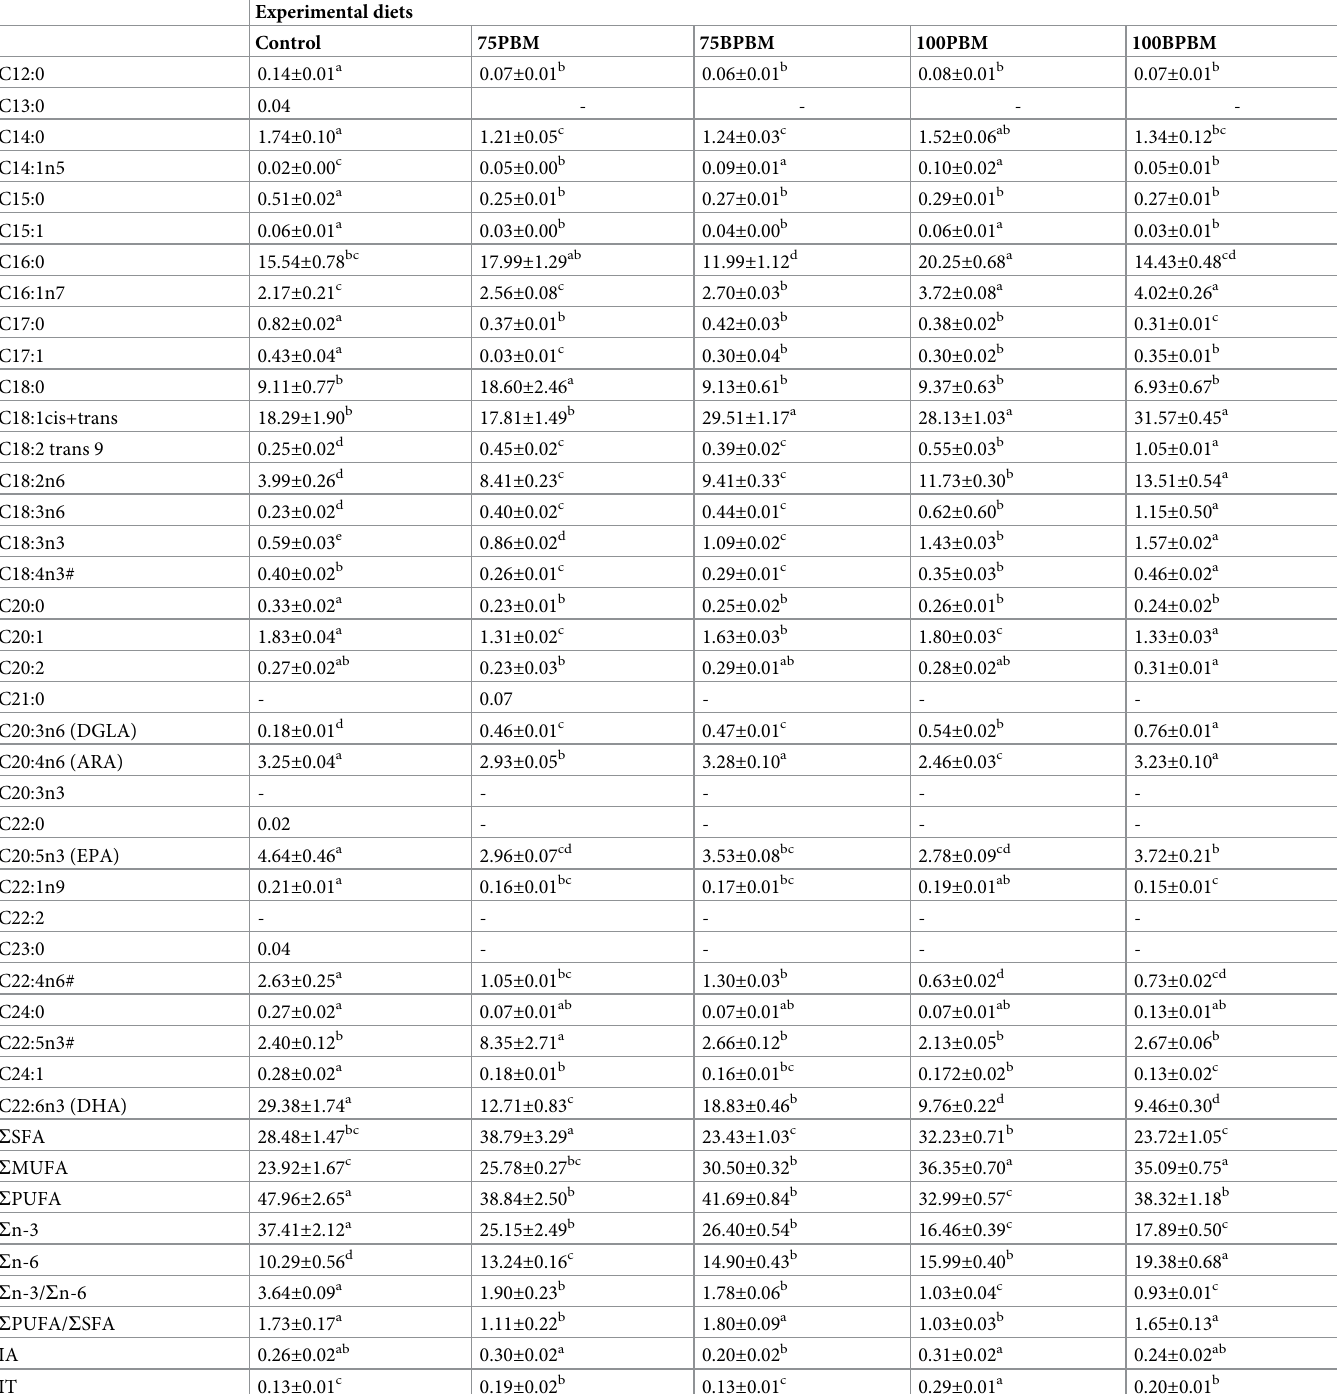
Table 6. Fatty acid profile (% of total fatty acids) in muscles of juvenile barramundi after the completion of feeding trial for 42 days. Experimental diets